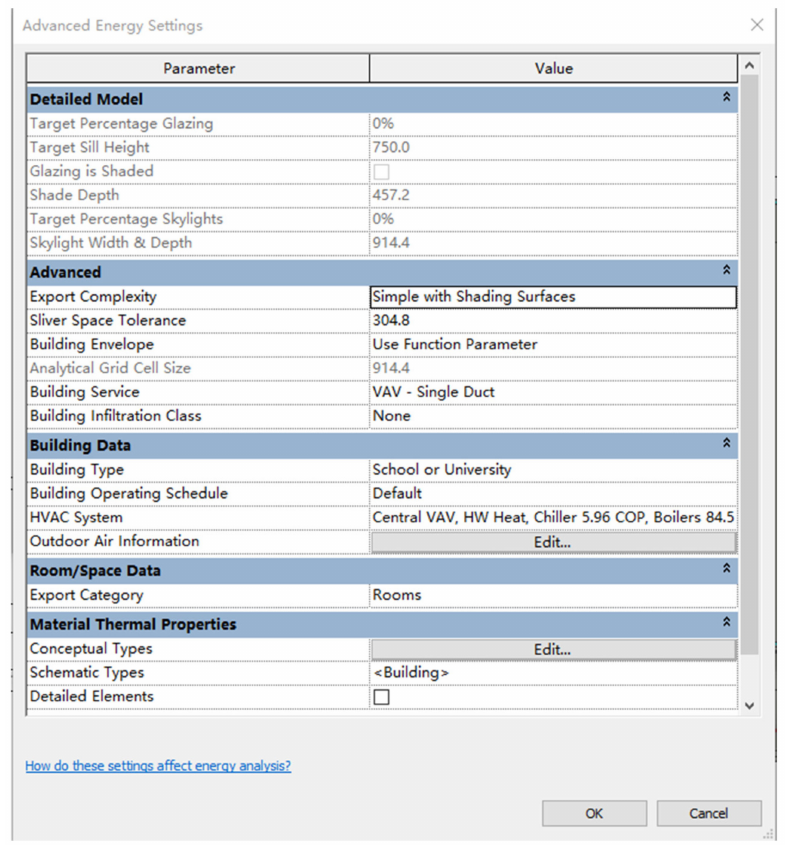
Figure A7. Case Study—Advanced Energy setting in